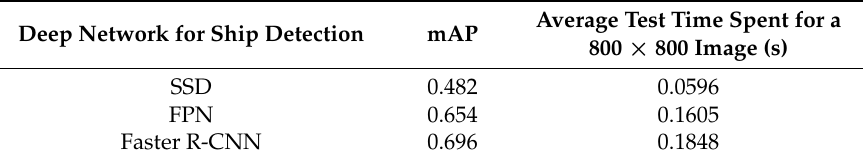
Table 2. Comparison of ship detection